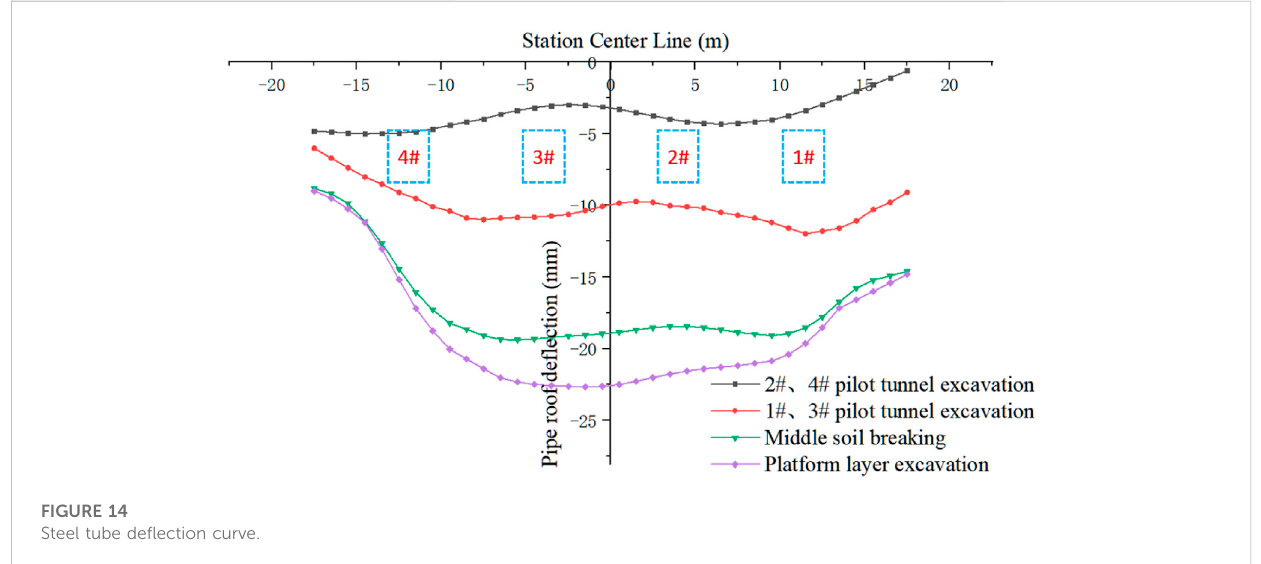
FIGURE 14 Steel tube de fl ection curve.